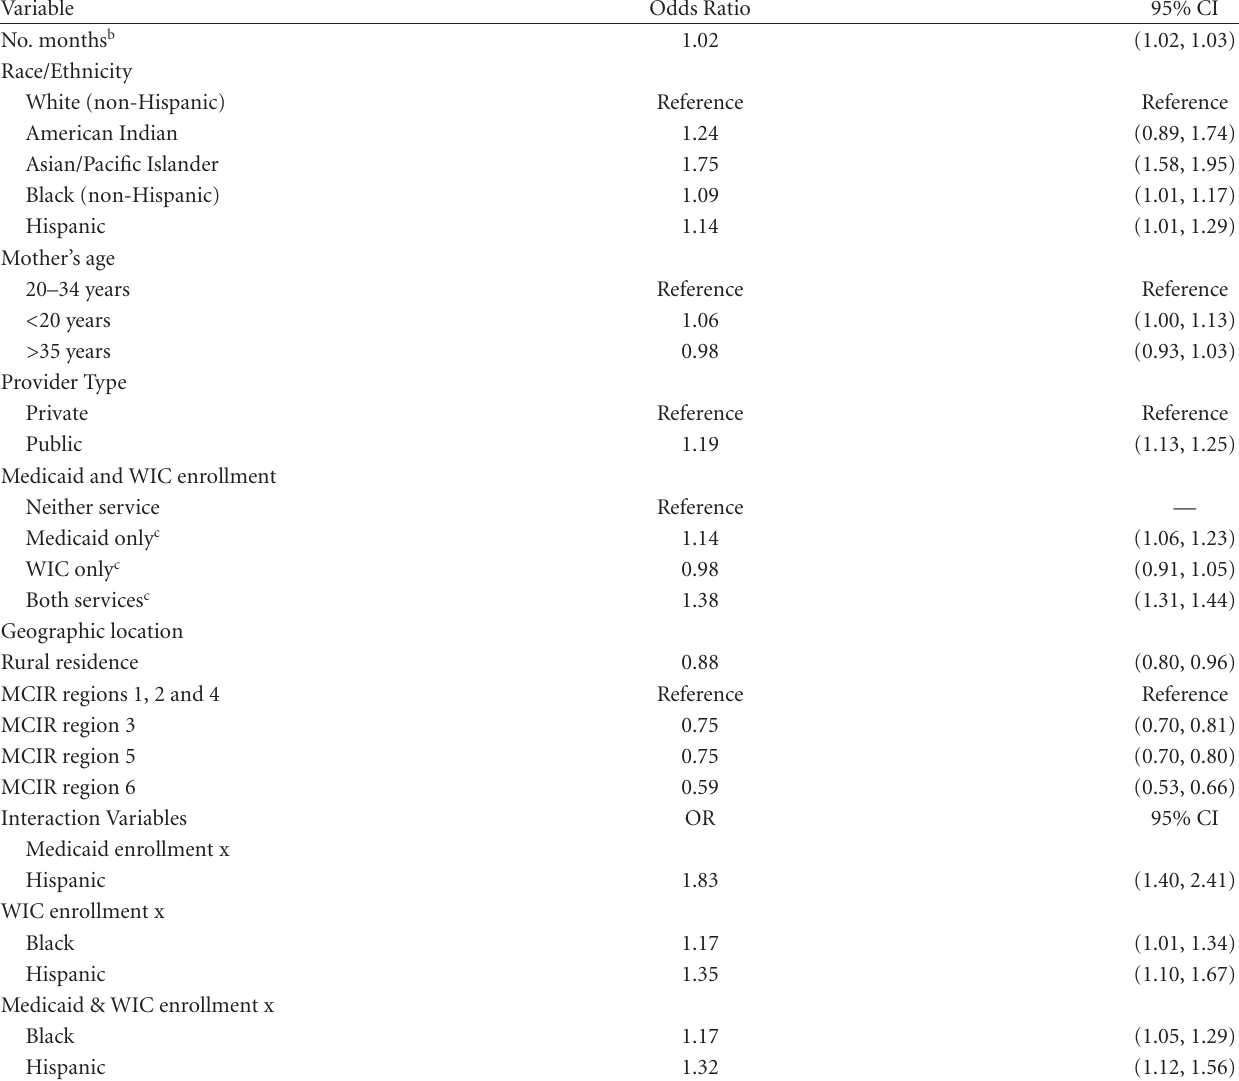
Table 2: Adjusted odds ratios and 95% confidence intervals of hepatitis A vaccination receipt a among 1-year-olds given by the final logistic regression model ∗